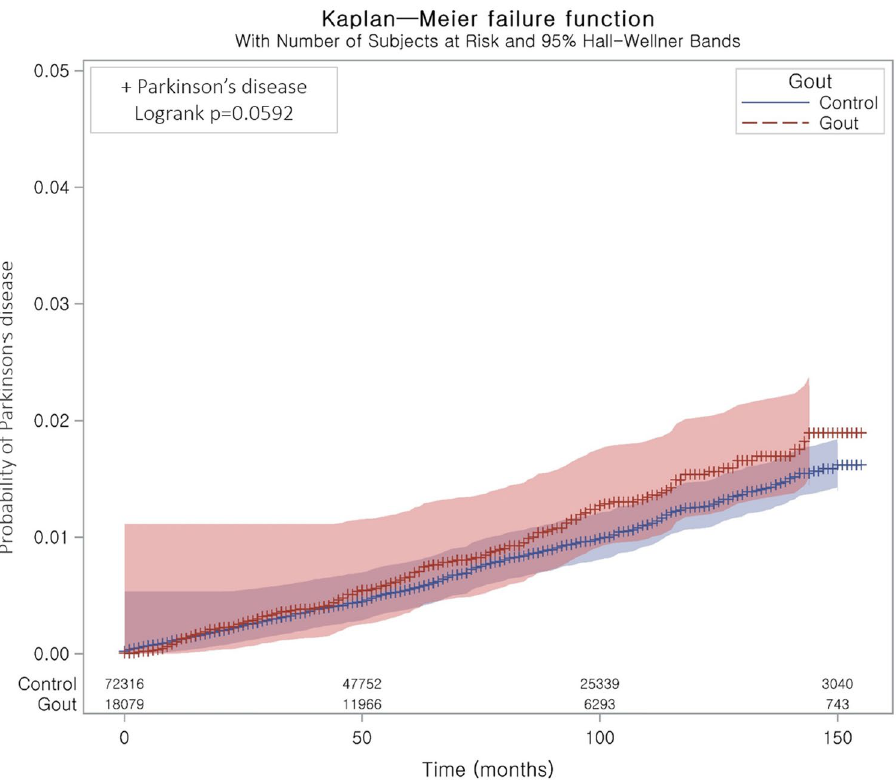
Figure 2. Kaplan ‒ Meier probability of the incidence of Parkinson’s disease in gout and the control participants within 13 years of the index